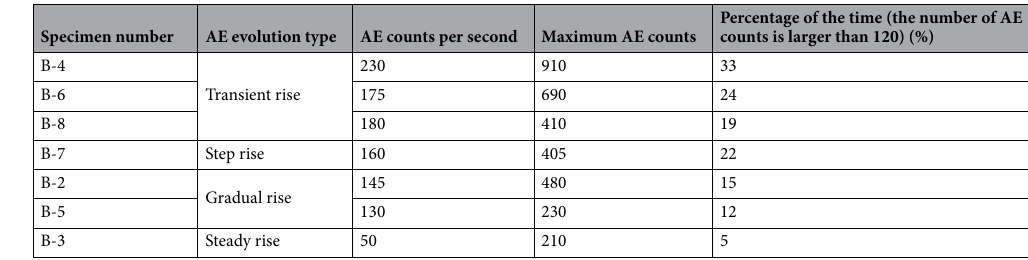
Table 2. Statistics of AE counts.